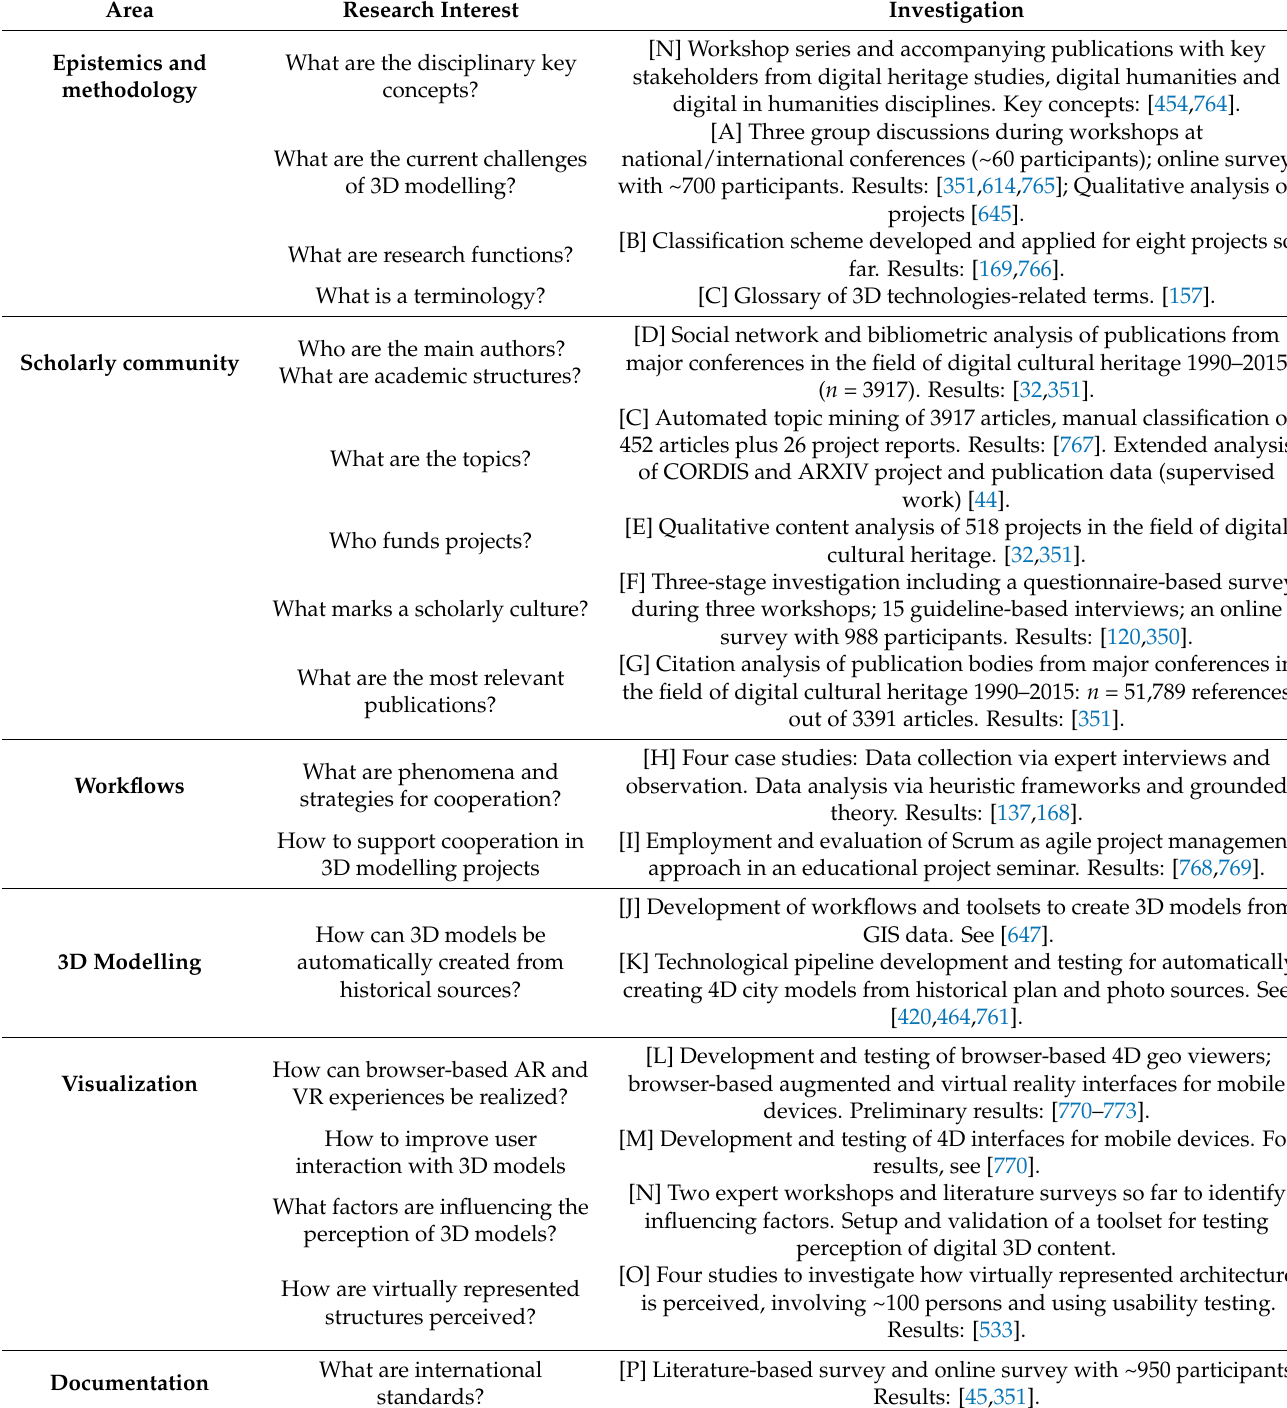
Table A1. Completed parts of the investigation based on (1) area of research, (2) research interest, and (3) the performed